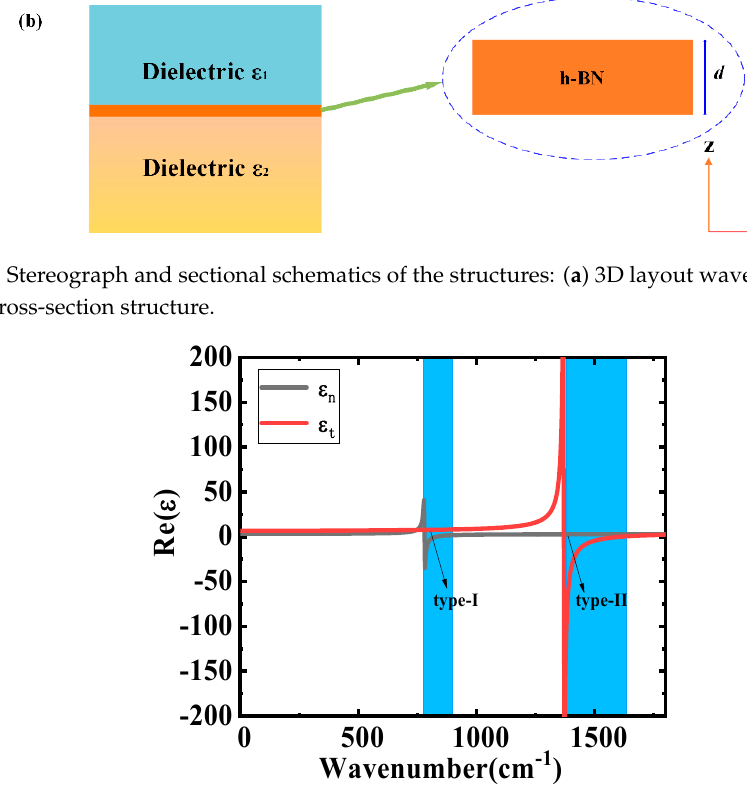
Figure 2. Re( ε ) as a function of wavenumber.